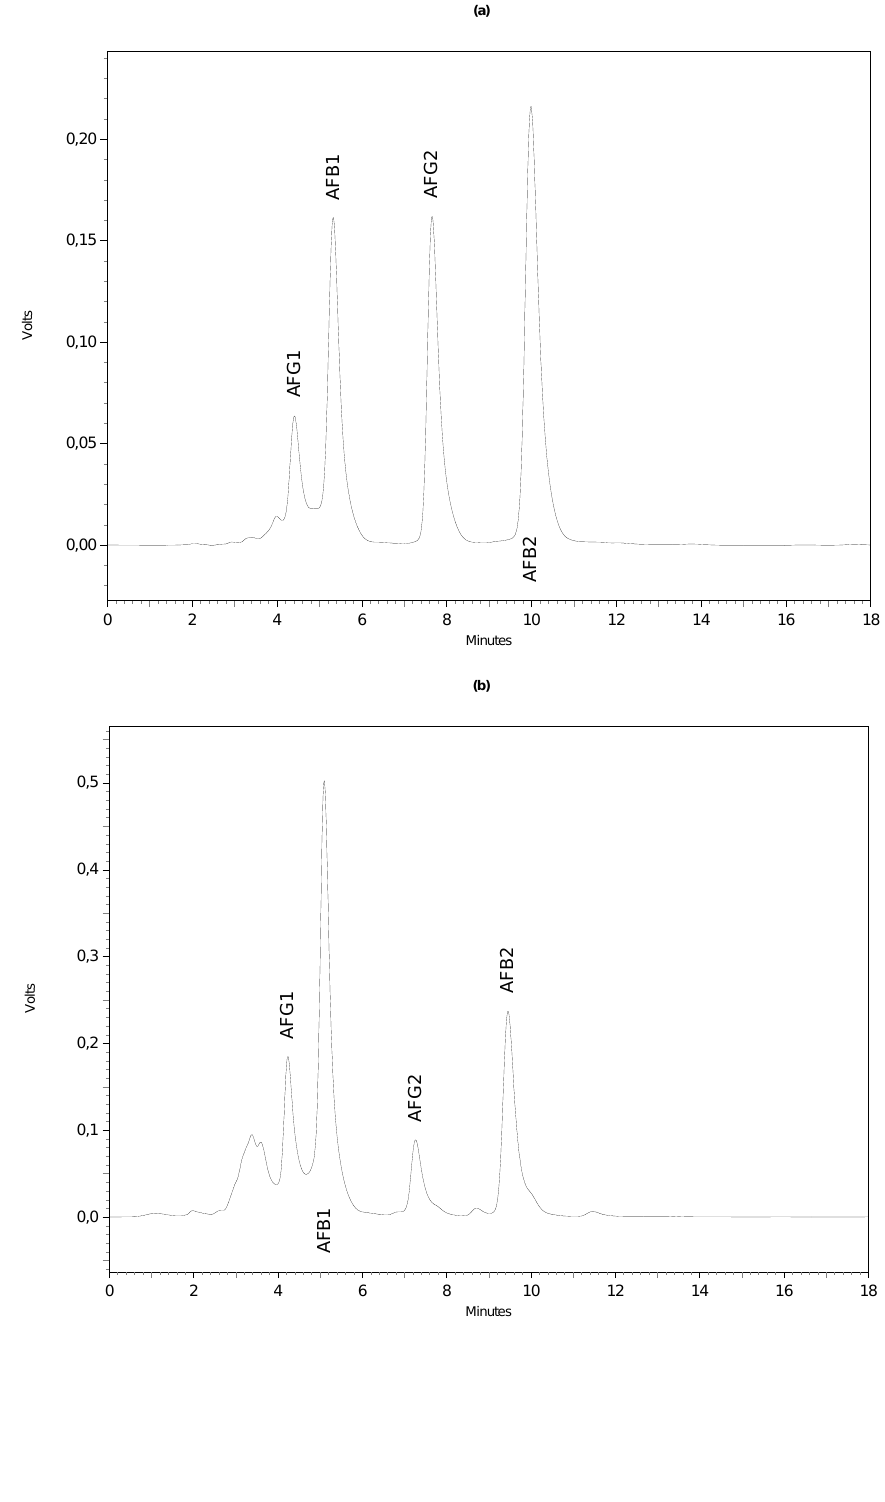
Figure 1. (a) Chromatogram showing the retention times of standards of aflatoxins (derivatised), B , G (derivatised) and G (nearly 5.39, 10.09, 4.45 and 7.62 min, B 1 2 1 2 respectively). (b) Chromatogram of aflatoxins in naturally contaminated peanut candy ( paçoca ) containing AFB (19,90 μ g · kg -1 ), AFB (11.43 μ g · kg -1 ), AFG 1 2 (3.30 μ g · kg -1 μ g · kg -1 ) and AFG 2